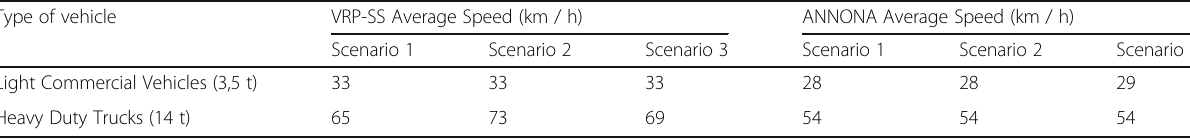
Table 10 Average Speed (km / h) according the type of vehicle and by each scenario